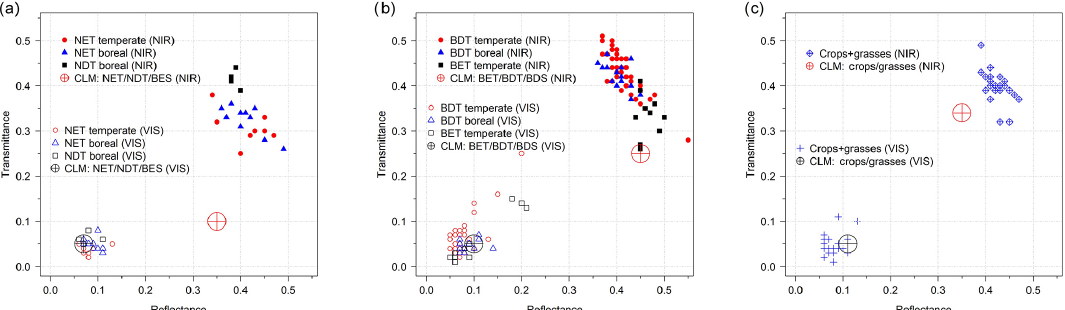
Figure 2. Leaf reflectance and transmittance in VIS (400–700nm) and NIR (701–2400nm) for different PFTs. Single species values are plotted to demonstrate the within- and between- PFT variation for (a) NET temperate and NET boreal, NDT boreal, (b) BDT temperate and BDT boreal, BET temperate, and (c) crops + grasses. The CLM default optical properties are plotted using large symbols.